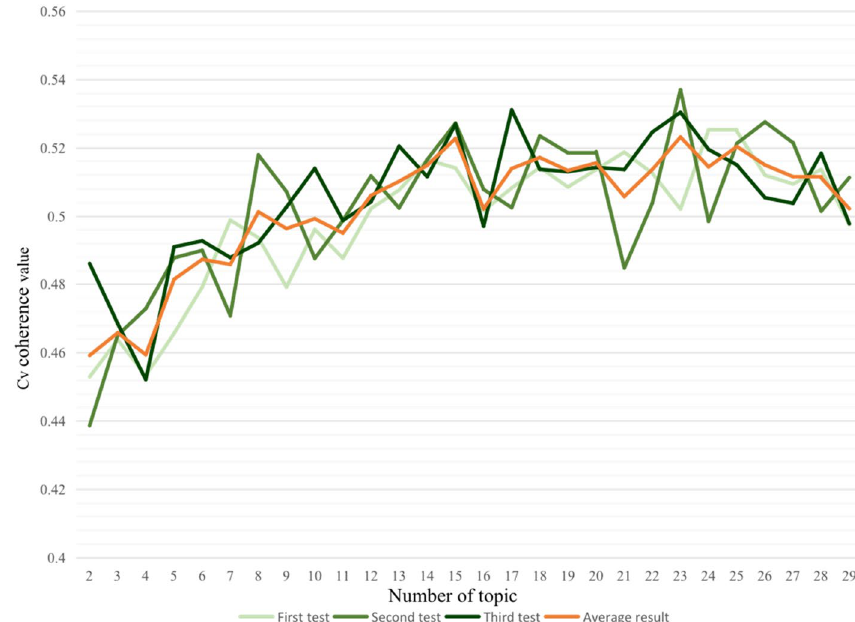
Fig. 4 Determination of the number of topics based on the Cv coherence